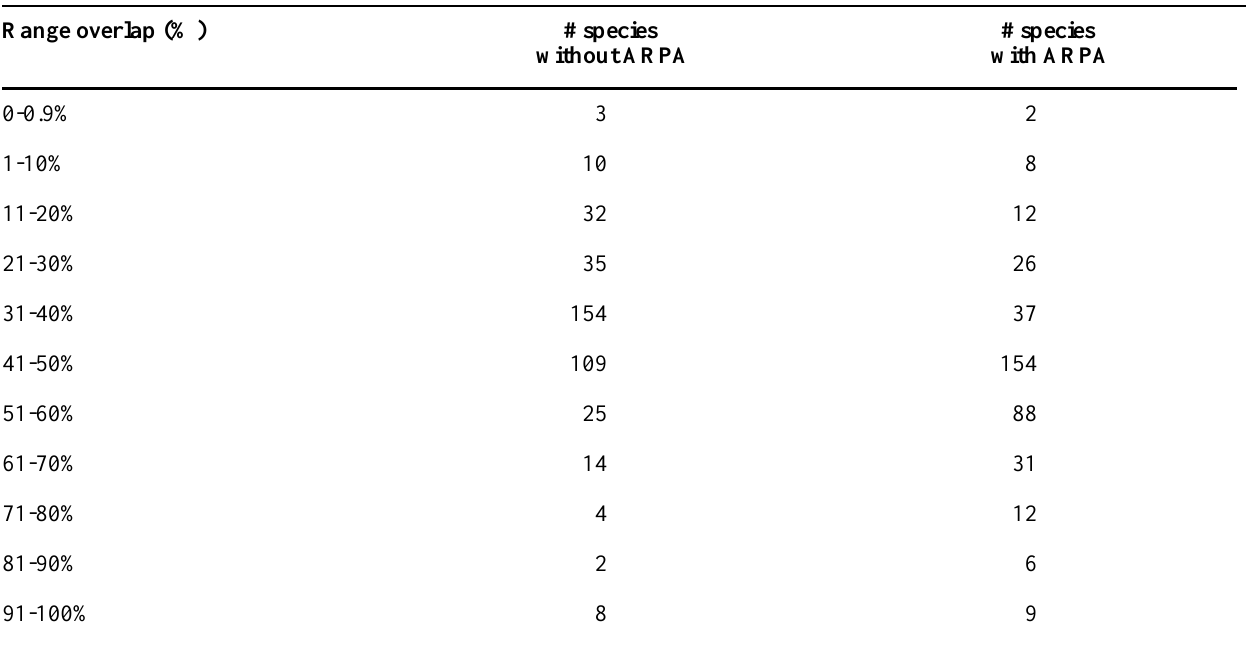
Table 3. Number of mammal species in different categories of range overlap with protected areas. Range overlap